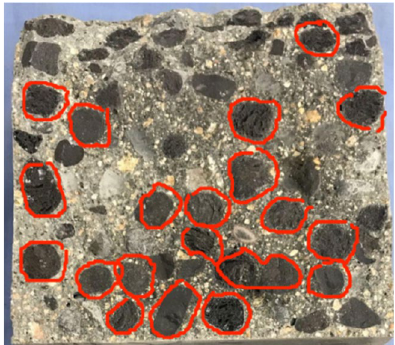
Figure 9. Splitting failure surface.